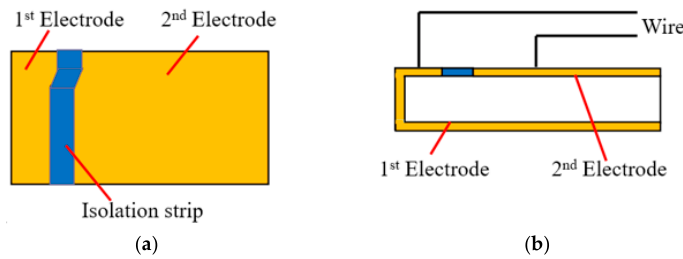
Figure 2. The two drawings of the PZT patch: ( a ) Top view; ( b ) Front view.